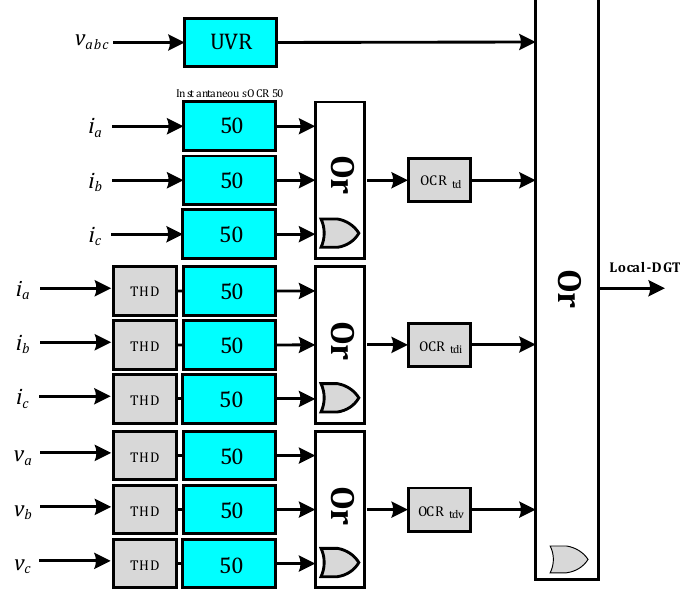
Figure 5. The proposed local DGU protection